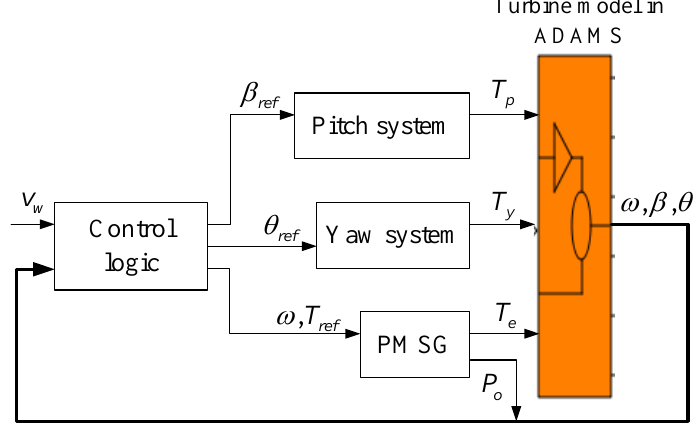
Figure 6. Block diagram of wind turbine system configuration.